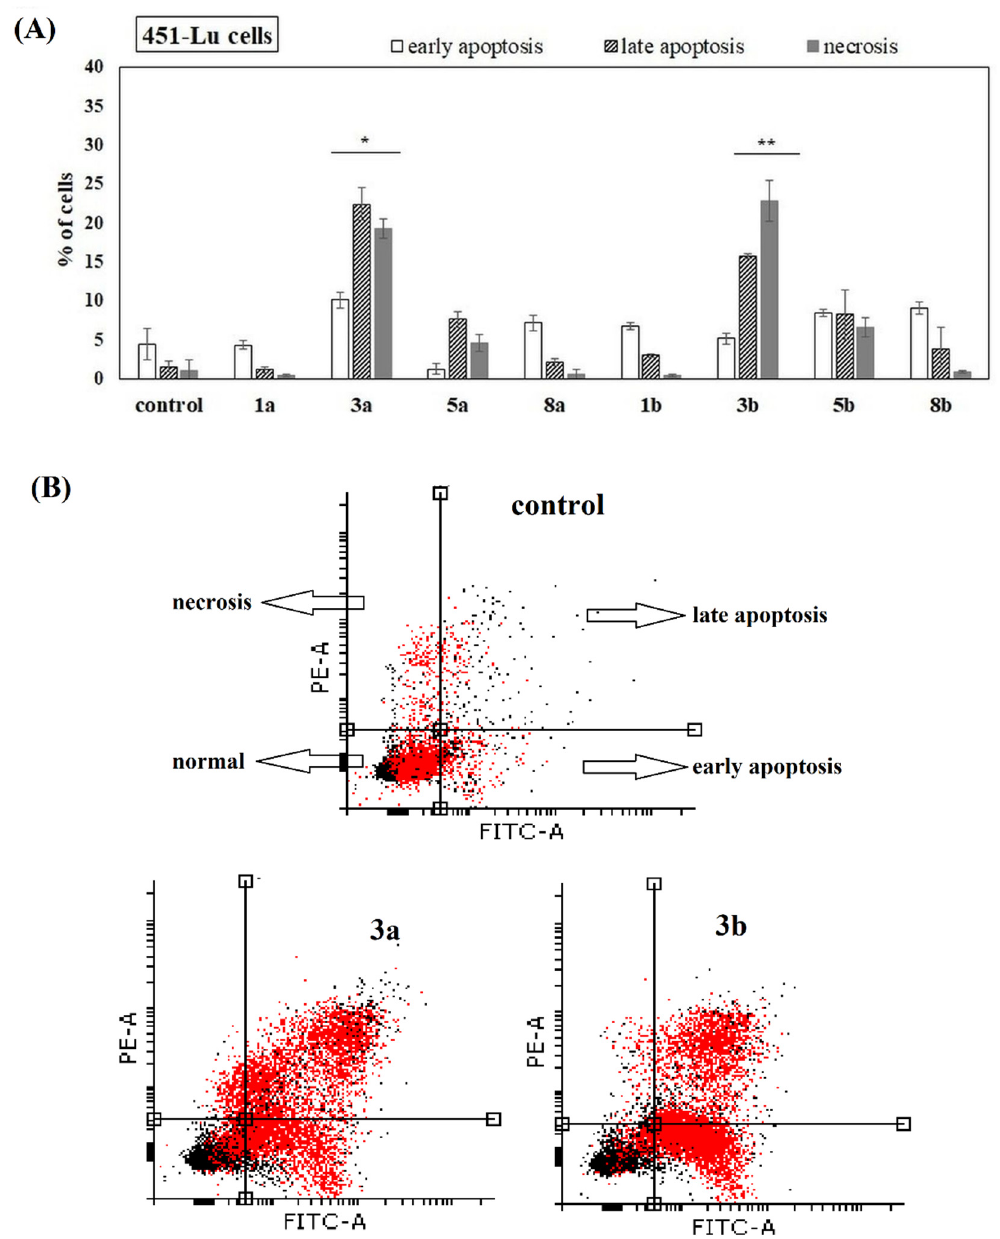
Figure 6. Induction of apoptosis in 451-Lu cells in the presence of the studied compounds. Cells were cultured for 72 h in the presence of the studied chemicals (at 100 µ M). The percentage of necrotic, early and late apoptotic cells was shown. The statistical significance was determined (* p < 0.05 and ** p < 0.001) ( A ). Representative histograms of events defined after forward and side scatters as cells (red dots) and debris (black dots) are shown ( B